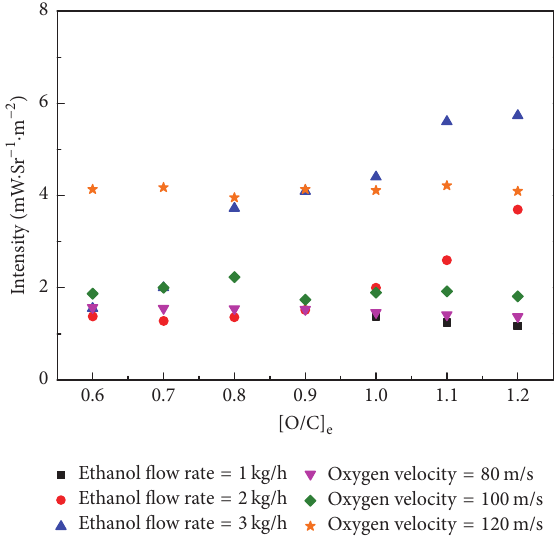
Figure 7: OH ∗ peak emission intensity in ethanol